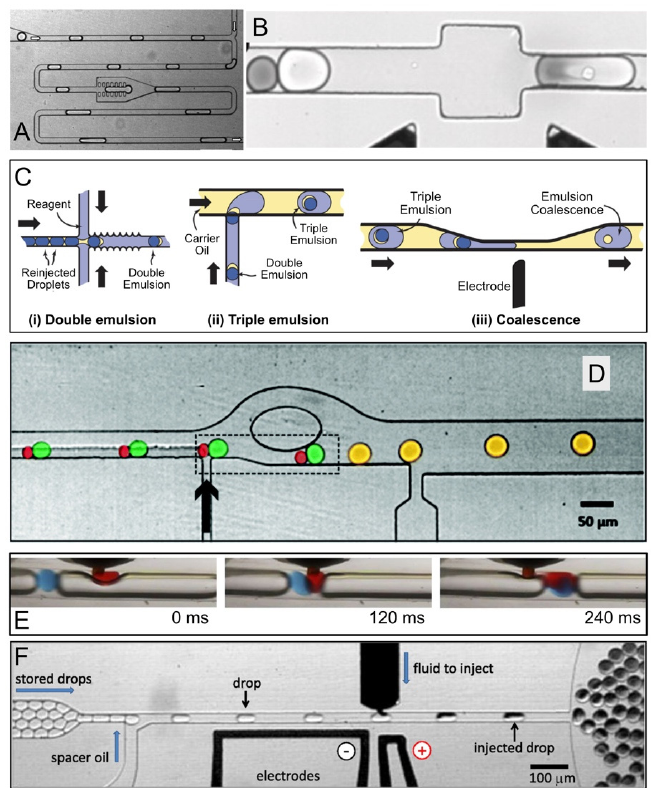
Figure 2. Droplet coalescence approaches. ( A ) The coalescence of two droplets within a pillar constriction-assisted droplet-merging device. Figure 2A was adapted from reference [44] with permission from the Royal Society of Chemistry. ( B ) A fusion module that delivered an alternating current (AC) field permitted electrically controlled merging of pairs of dye-containing droplets and cell-containing droplets. Figure 2B was adapted from reference [60], complying with the License for PNAS Articles. ( C ) Schematic of a different electrocoalescence workflow assisted with triple emulsification. At step (i), reinjected droplets are enveloped by an aqueous reagent phase in a hydrophilic channel. The resulting double emulsion travels to a hydrophobic junction at step (ii) where carrier oil encapsulates it to form a triple emulsion. At step (iii), the encapsulated double emulsion is ruptured in the presence of an electric field. Figure 2C was adapted from reference [50] with permission, copyright American Institute of Physics. ( D ) Passive microfluidic droplet coalescence through the addition of a destabilizing alcohol. Perfluorobutanol is added through the channel indicated by the black arrow, causing downstream coalescence of paired droplets. Droplets are false colored. Figure 2D was adapted from reference [45] with permission from the Royal Society of Chemistry. ( E ) A sequence of still images showing the direct injection of red-dyed octadecene into blue-dyed octadecene droplets, using Ar gas as a spacer and PFPE as the carrier fluid. Figure 2E was adapted from reference [61] under the Creative Commons Attribution license. ( F ) A picoinjector microfluidic device. The spacer adds oil from a side channel to space the droplets. The picoinjector injects fluid by merging the droplets with a pressurized channel containing the reagent. Picoinjection is triggered by an electric field, which is applied by the electrodes. Figure 2F was adapted from reference [41], complying with the License for PNAS